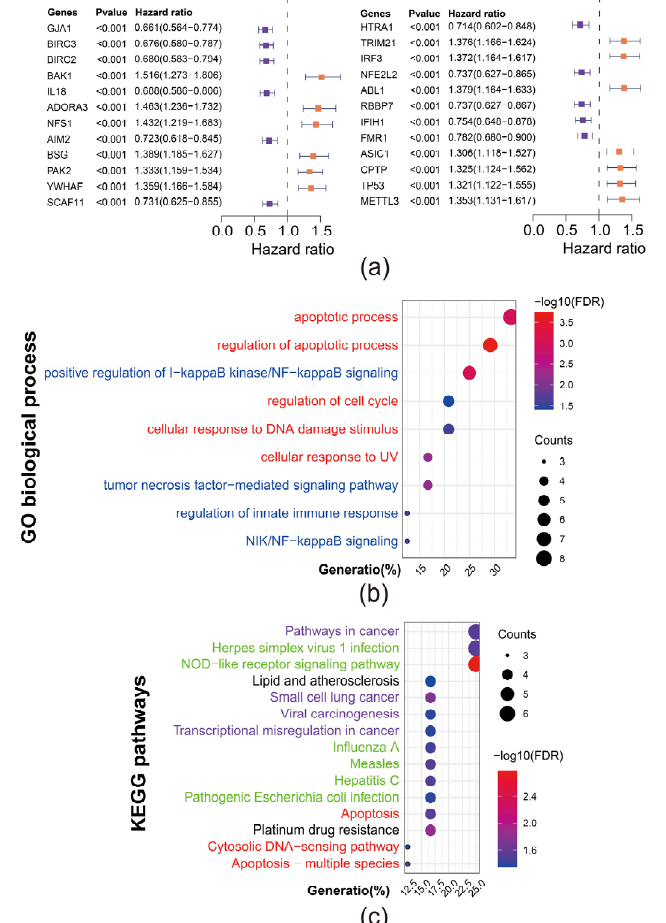
Figure 1. Identification of 24 prognostic pyroptosis related genes (PRGs) in DLBCL. ( a ) Univariate Cox regression identified 24 prognostic PRGs in DLBC; ( b ) Gene ontology annotation of 24 prognostic PRGs; ( c ) KEGG pathway enrichment analysis of 24 prognostic PRGs .